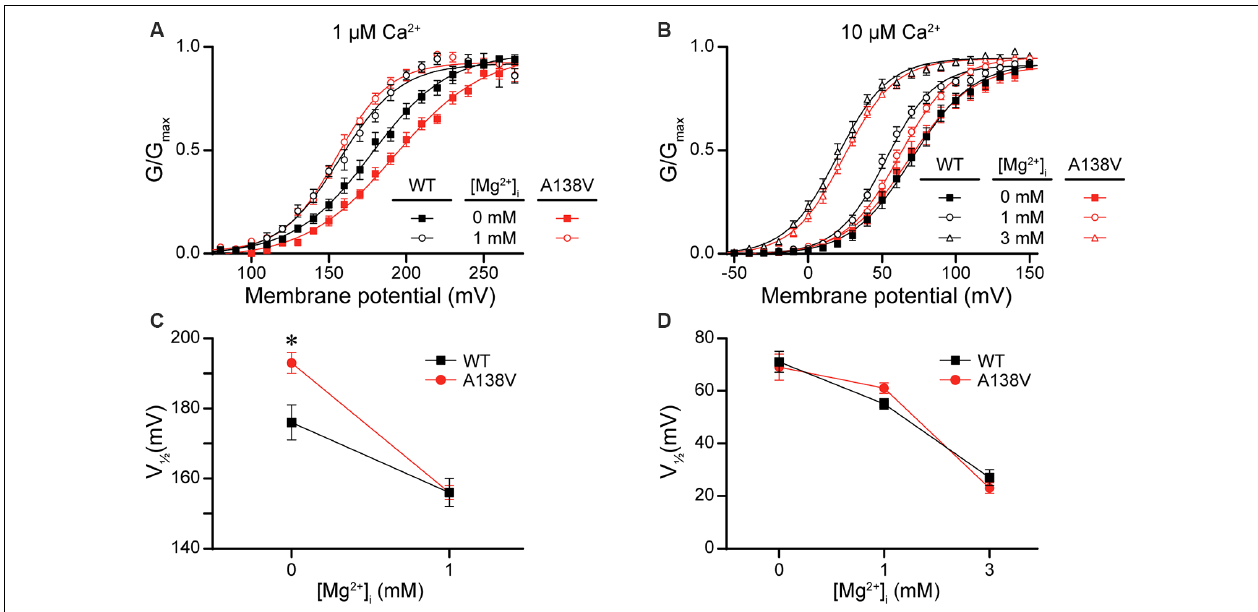
FIGURE 10 | Effects of A138V on Mg 2 + -dependent activation of BK currents. Experiments were performed on the hBK VYR splice variant background in symmetrical K + solutions using the voltage protocols from Figure 2 . (A,B) G–V relationships from WT and A138V channels in the presence of 0-, 1-, or 3-mM intracellular Mg 2 + at 1- (A) or 10- µ M Ca 2 + (B) . (C,D) V 1 / 2 vs. Mg 2 + concentration plot for currents obtained in 1- (C) and 10- µ M Ca 2 + (D) . At 1- µ M Ca 2 + , the V 1 / 2 of WT and A138V currents were left-shifted in 1-mM Mg 2 + , compared with 0-mM Mg 2 + . At 10- µ M Ca 2 + , the V 1 / 2 values were left-shifted in 1- (WT, P = 0.003) and 3-mM Mg 2 + (WT, P < 0.0001; A138V, P < 0.0001), compared with 0-mM Mg 2 + , and differences in V 1 / 2 values between WT and A138V were eliminated. ∗ P < 0.05, one-way ANOVA with Bonferroni post hoc comparing V 1 / 2 values between the constructs at each Mg 2 + condition and V 1 / 2 values between Mg 2 + conditions for each construct, within each Ca 2 + concentration. N = 6–12 recordings per construct per treatment